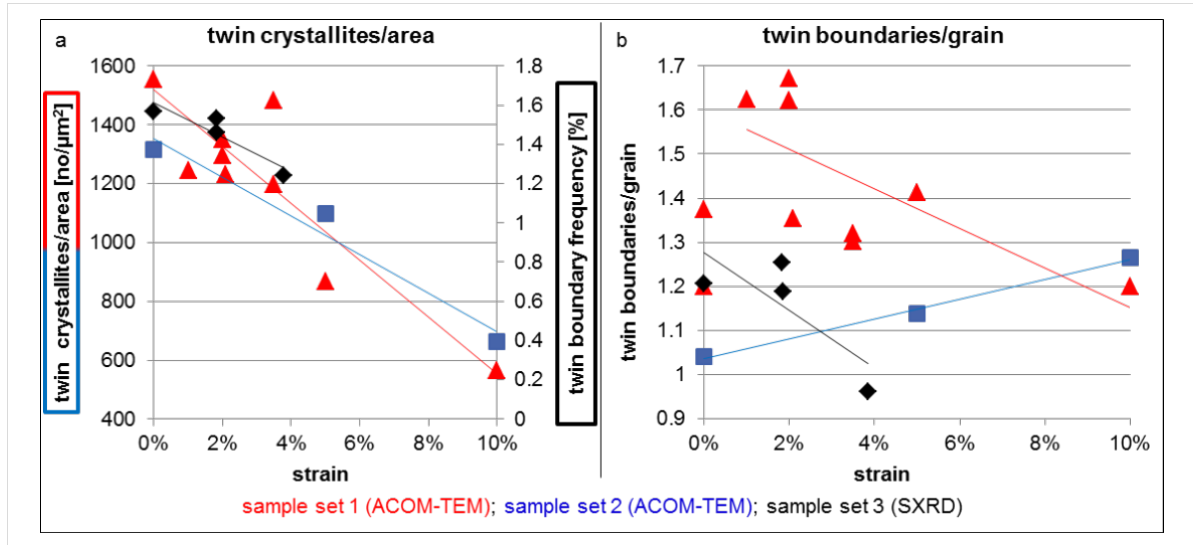
Figure 6: a) Twin crystallites/area as a function of strain based on the ACOM-TEM analysis (ncPd 1: red, ncPd 2: blue) and twin boundary frequency ( f twin ) as a function of strain (ncPd 3: black) derived from in-situ SXRD data. b) Twin boundaries/grain as a function of strain based on the ACOM-TEM (ncPd 1: red, ncPd 2: blue) and in-situ SXRD analysis (ncPd 3: